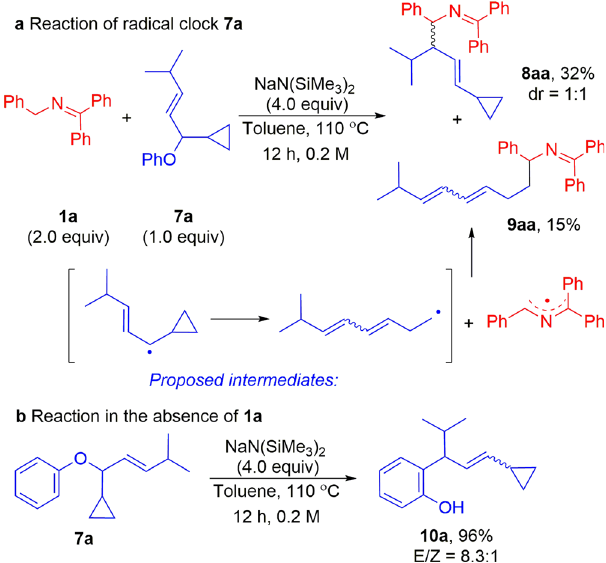
Fig. 7 Mechanistic experiments. a Radical clock study with 7a . b Control experiment in the absence of ketimine 1a .